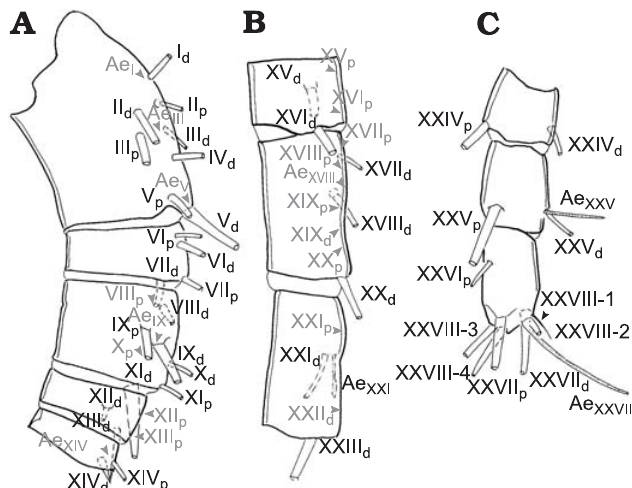
Fig. 1. Coding of the antennulary setae, shown on the female of cyclopid copepod Apocyclops cf. ramkhamhaengi (MIZ 2/2015/9) from Townsville (Australia), extant species. A . Segments 1 − 5 (I − XIV). B . Segments 6 − 8 (XV − XXIII). C . Segments 9 − 11 (XXIV − XXVIII). Armature elements denoted by black and grey codes are present in the male of Euryte ro- busta ; codes in black denote setae or aesthetascs present in female in the Apocyclops panamensis group; Roman numeral refers to the ancestral segment on which the seta is inserted; p or d means anteroproximal- or anterodistal seta; Ae with Roman numeral in subscript means an aesthetasc inserted on the ancestral segment given in the XXVI, while the anterodistal seta of segment XXVI failed to form. Four setal elements of segment XXVIII are indi- cated as XXVIII-1–4.